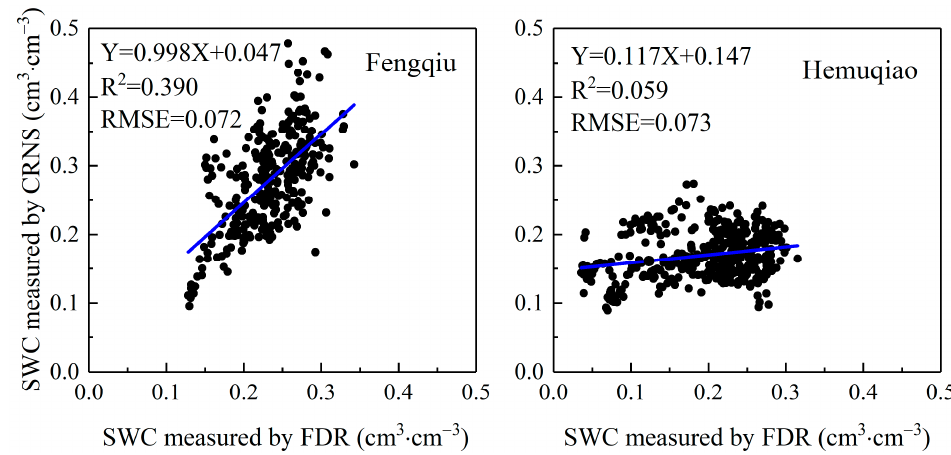
Figure 5. Correlation between the daily variations in SWC measured by CRNS and FDR.